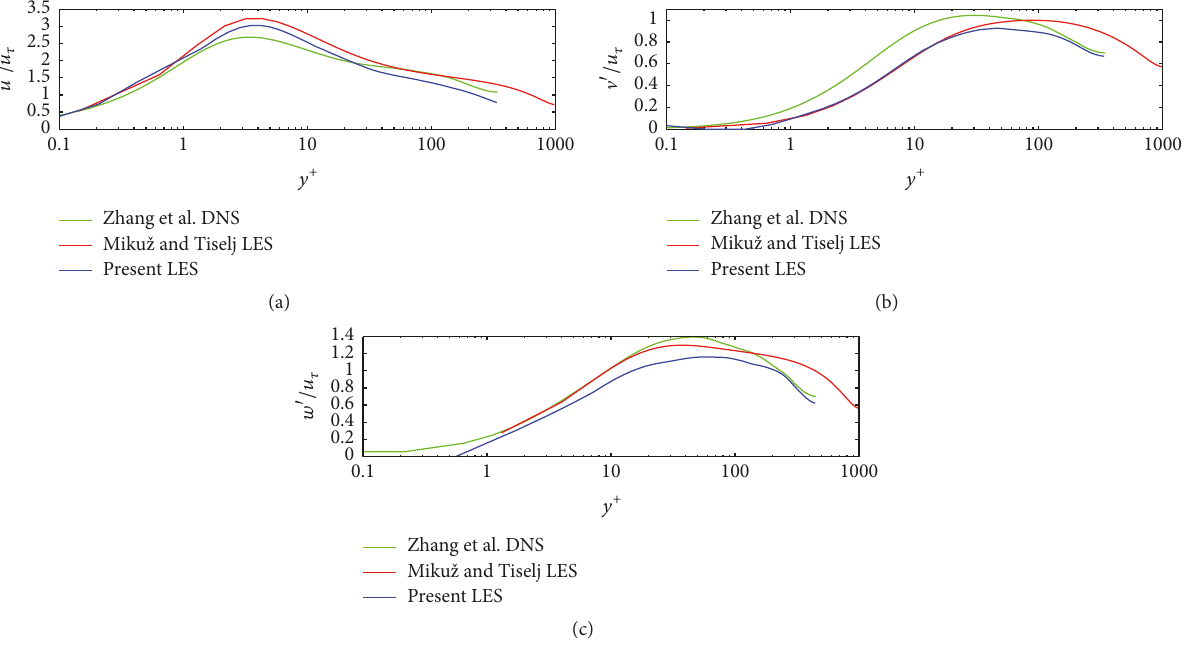
Figure 6: Comparison of normalized streamwise (a), crosswise (b), and spanwise (c) velocity fluctuations.